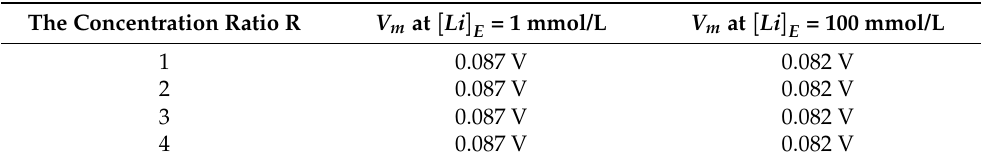
Table 22. The table shows the membrane potential values at extracellular lithium concentration of 1 mmol/L and 100 mmol/L, at different concentration ratios R and based on the classical transport of Li-6 as in graph (a) of Figure 9.